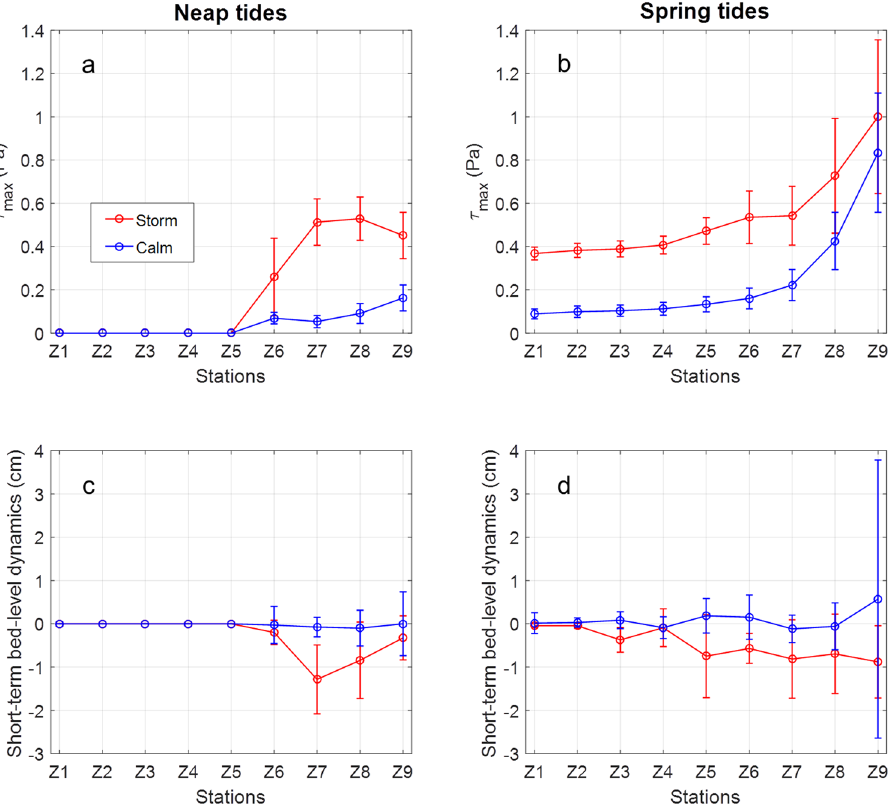
Figure 5. Comparison of the total BSS ( τ max ) (panel a and b), and the corresponding short-term bed-level dynamic (panel c and d) during storm and calm conditions over neap or spring tides at the exposed Zuidgors site. The positive and negative values in bed-level dynamics indicate deposition and erosion, respectively. The plotted data is the mean value over a few tidal cycles in the same category (e.g. neap-storm, neap-calm and etc.), and the error bars are the corresponding standard deviations. The total number of neap-storm, neap-calm, spring-storm and spring-calm tidal cycles is 4, 18, 3 and 29, respectively. Storm condition is defined as when the incident significant wave height at Z9 exceeds 0.5 m, whereas the calm condition is defined as when the incident significant wave height is below 0.1